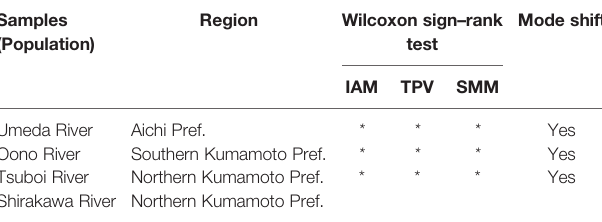
TABLE 2 | Bottleneck analysis of Spartina alterni fl ora populations in Japan using three models: IAM, SMM, and TPM. Samples (Population)